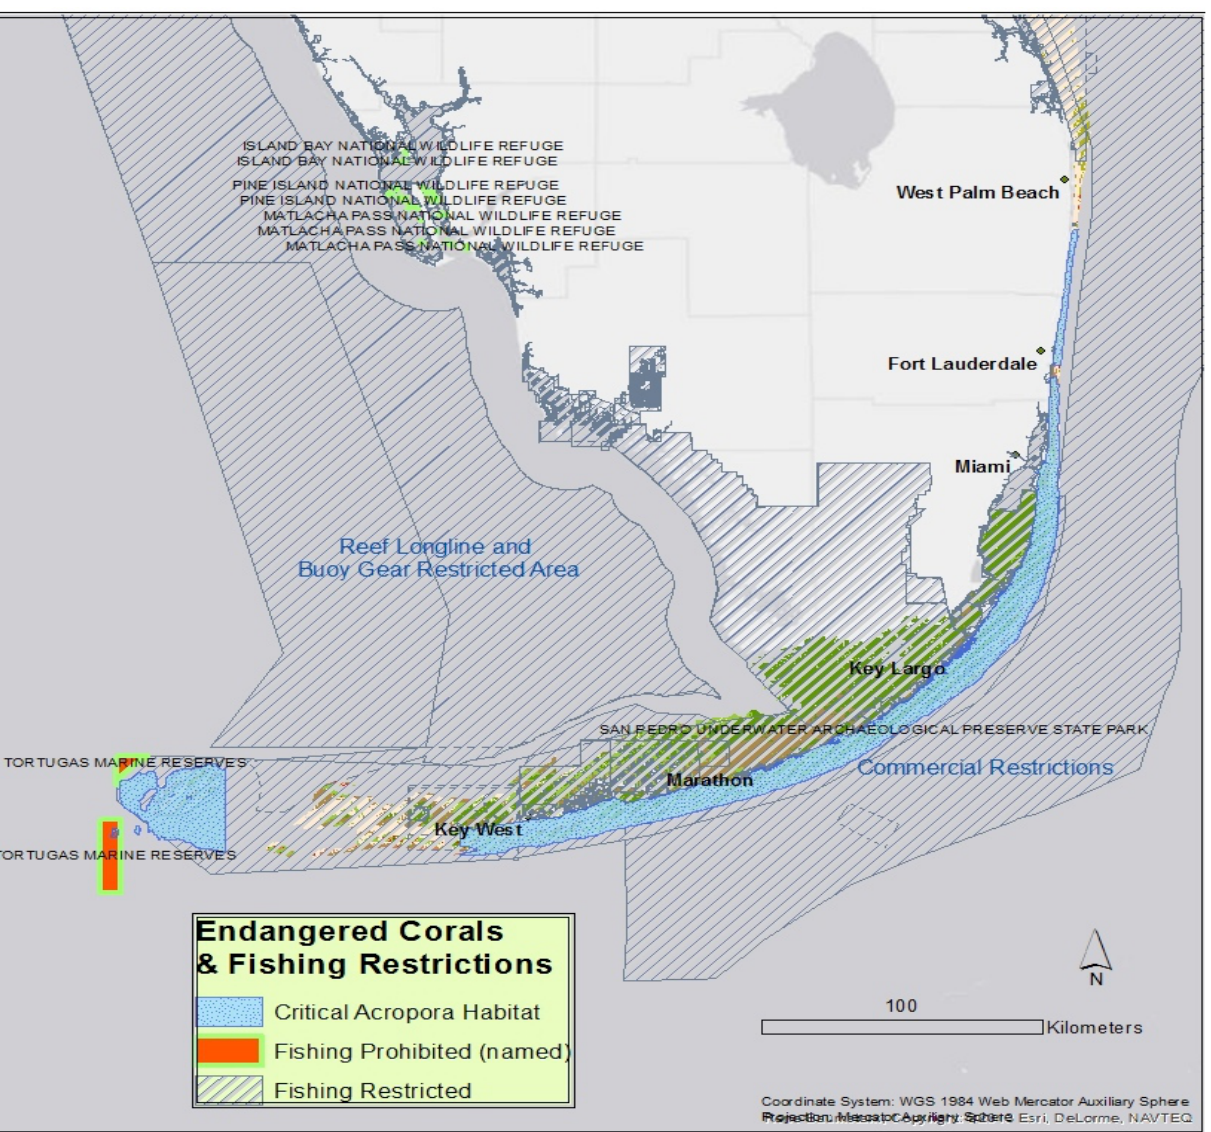
Figure 1. The Florida Reef extends from north of West Palm Beach to west of Key